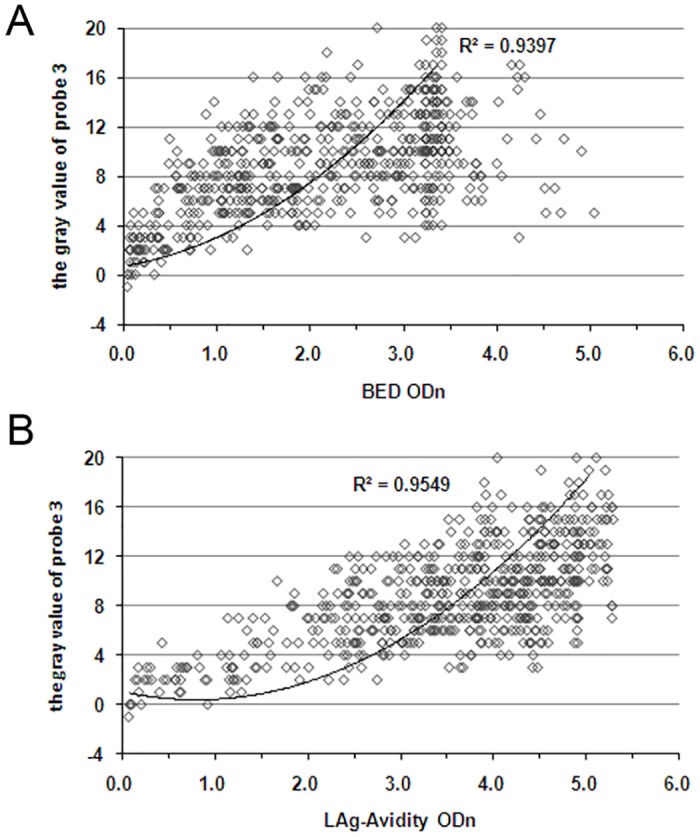
Concordance between the gray value of DIGSSA and BED-CEIA ODn or LAg-Avidity ODn.(A) concordance between the gray value of DIGSSA and BED-CEIA ODn, the horizontal arrows corresponds to a probe 3 cutoff of 3.50 and the vertical arrows corresponds to a BED ODn cutoff of 0.8. (B) concordance between the gray value of DIGSSA and LAg-Avidity ODn, the horizontal arrows corresponds to a probe 3 cutoff of 3.50 and the vertical arrows corresponds to a LAg-Avidity cutoff ODn of 1.5.